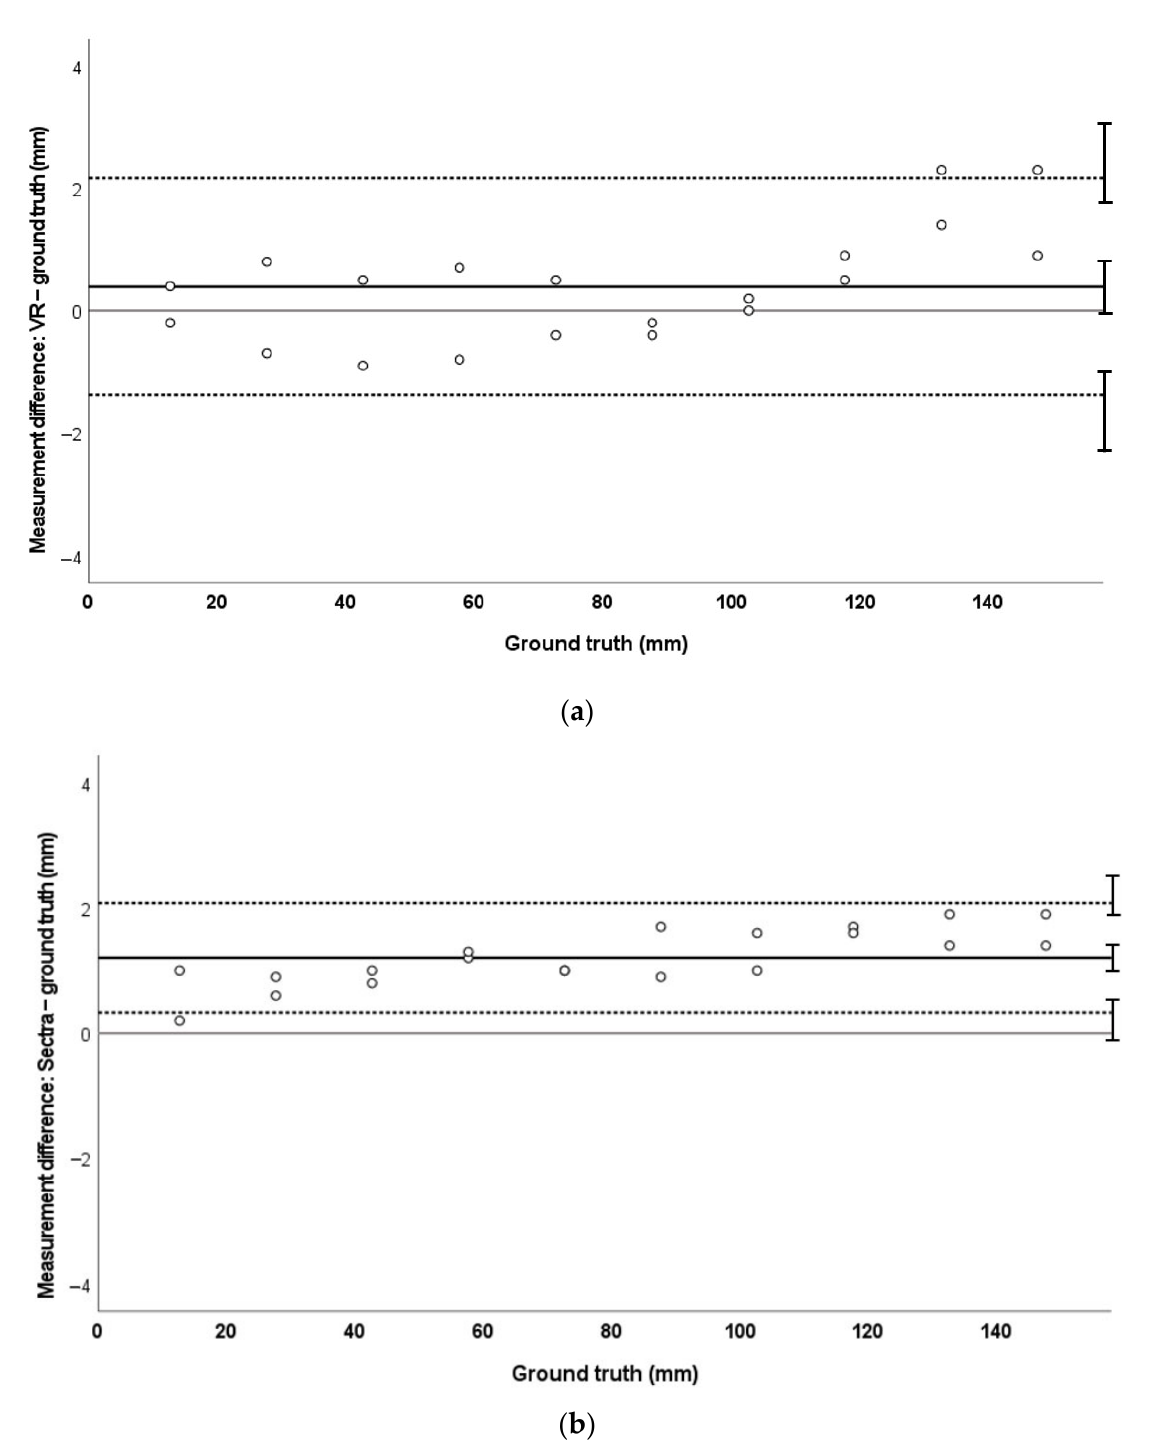
Figure 4. Bland–Altman plots demonstrating measurement agreement for CT measurements against ground truth in VR ( a ) and Sectra ( b ).